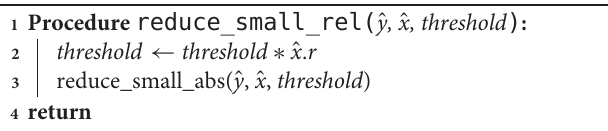
Algorithm 4: Condense terms smaller than